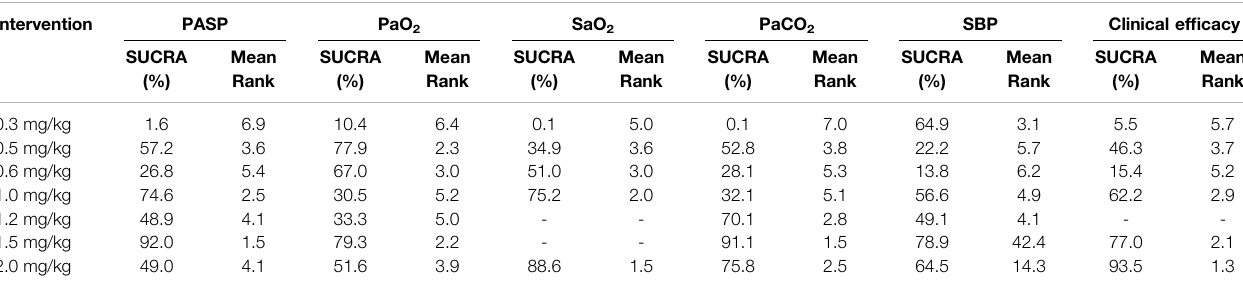
TABLE 3 | Ranking of different doses of sildena fi l for PPHN.